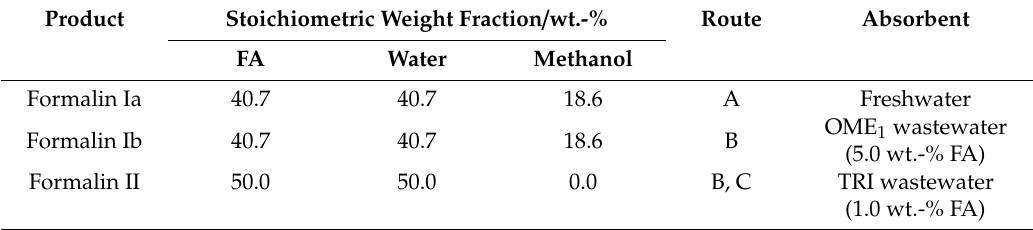
Table 10. Products of formalin synthesis using di ff erent